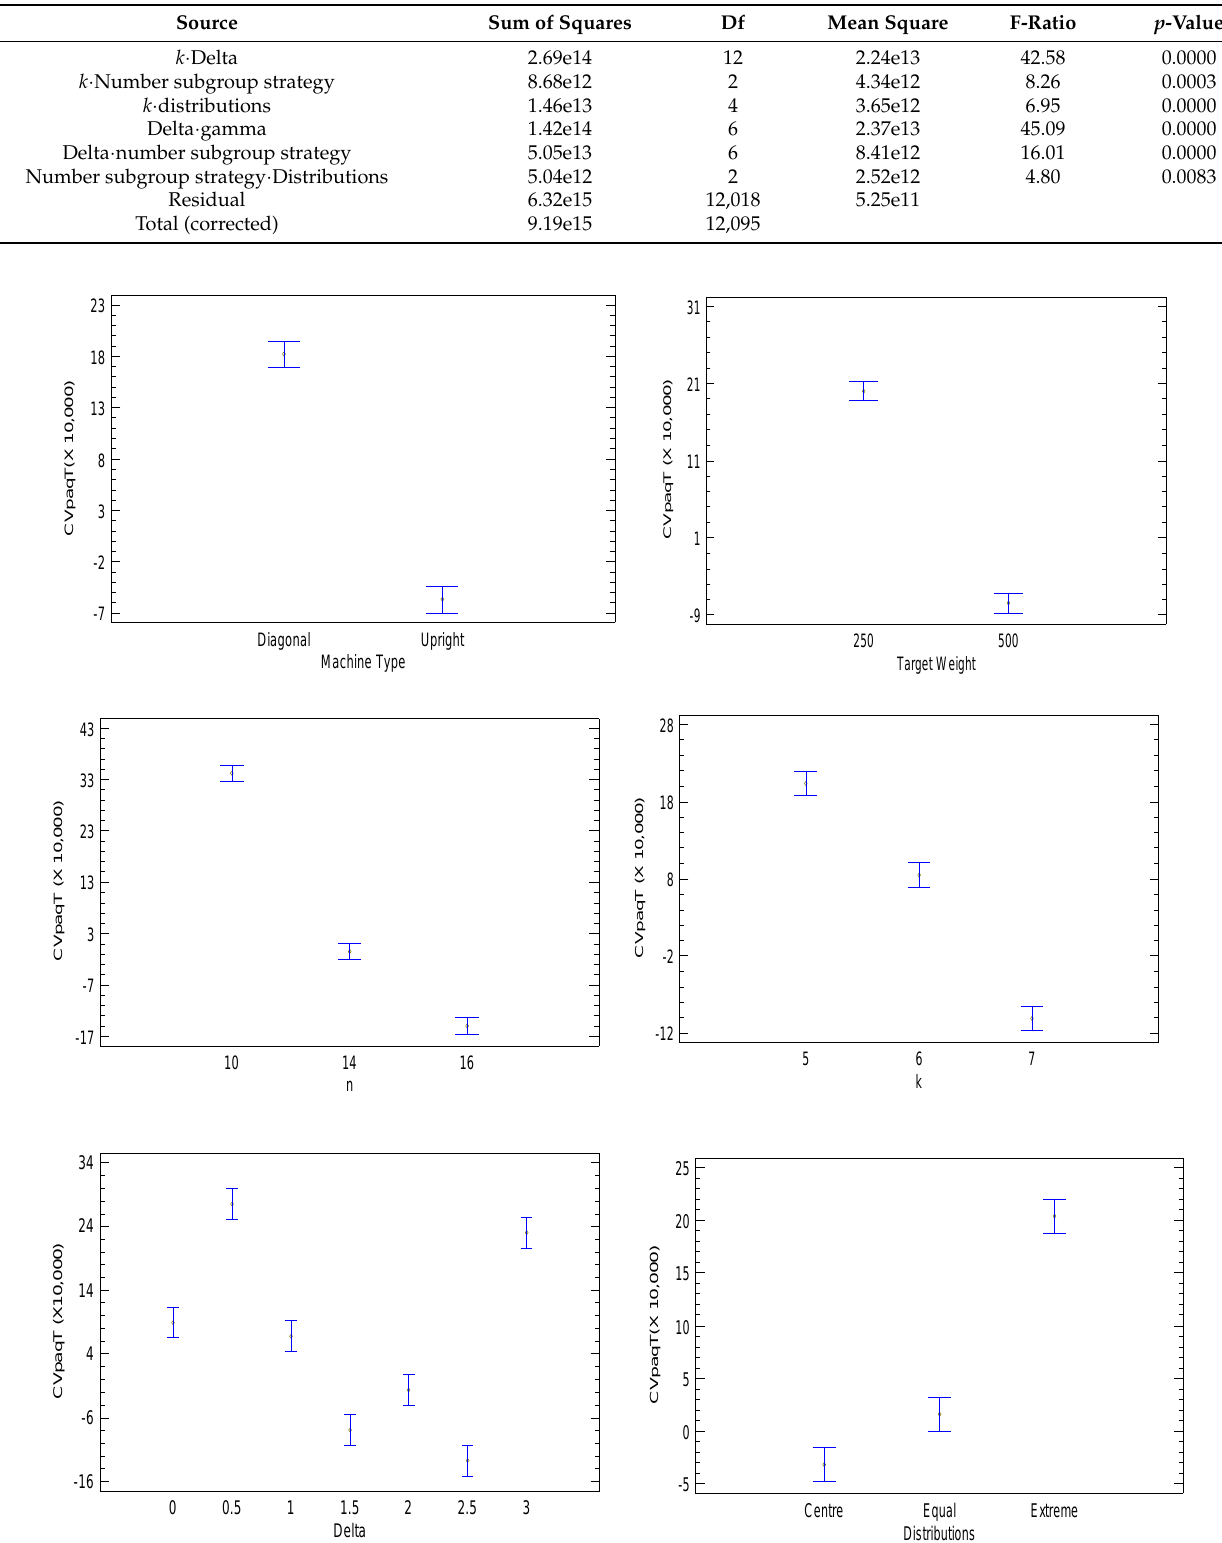
Figure 7. Means and least significant difference (LSD) intervals for the main significant factors.